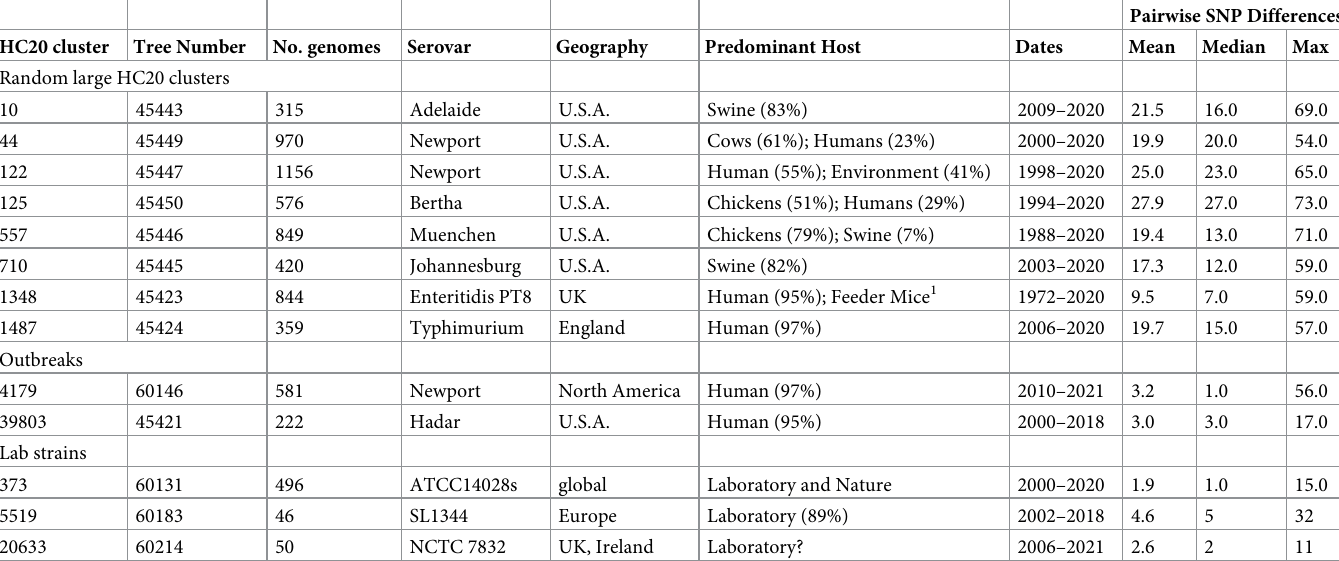
Table 2. General properties of HC20_373 and other HC20